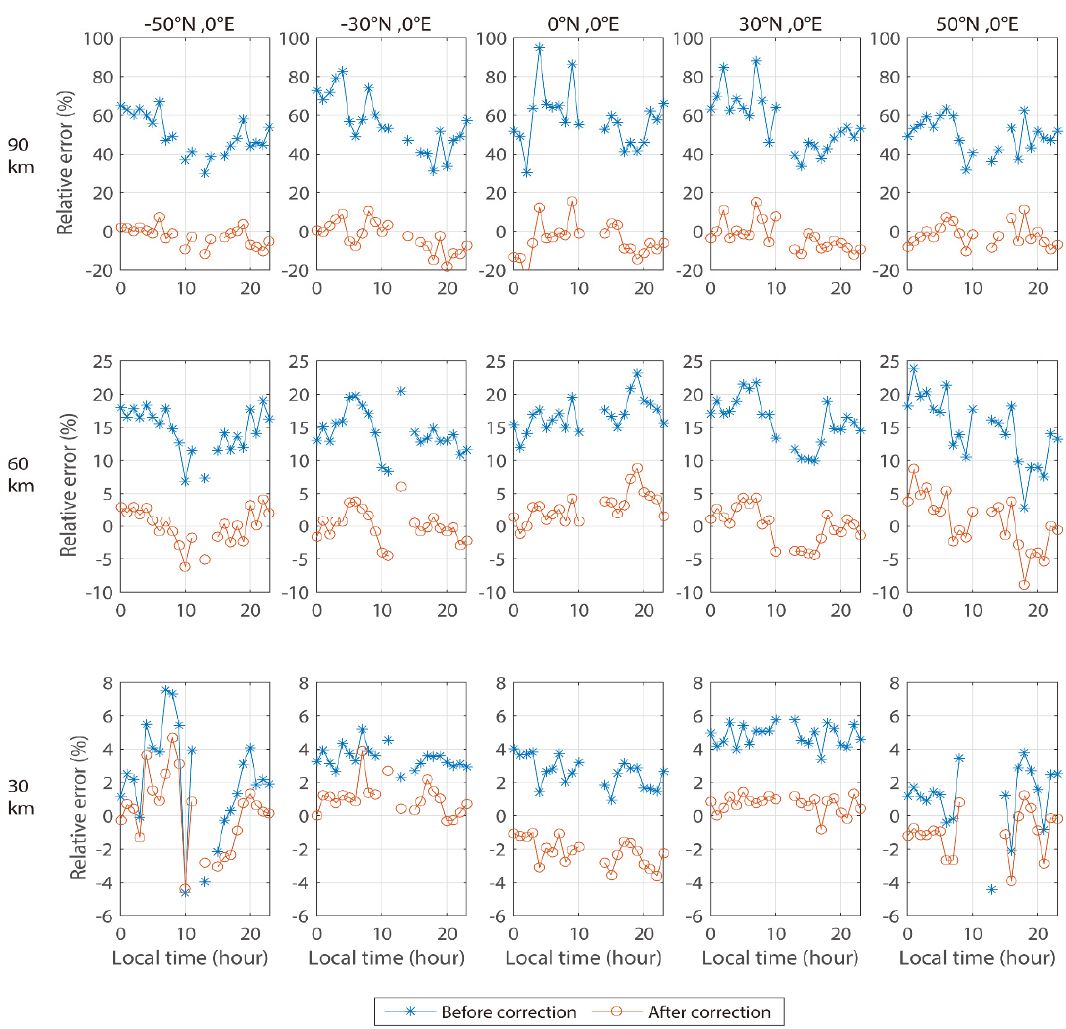
Figure 5. The relative error between NRLMSISE-00 and TIMED / SABER density before and after correction varies with local time in 2008. The blue line refers to the relative error before correction. The red line refers to the relative error after correction.